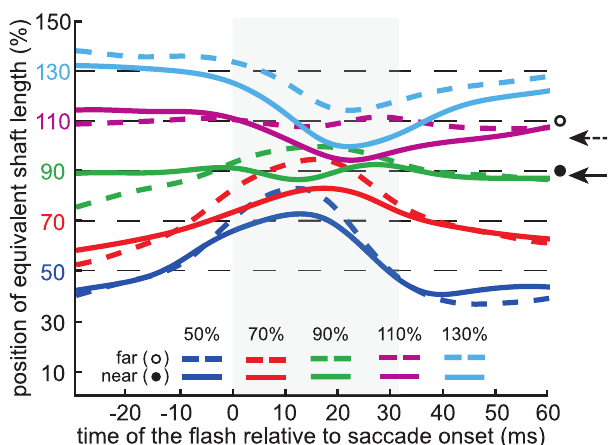
Figure 6. Averaged mislocalization curves for each flash location in the control experiment. Mislocalization was quantified relative to the equivalent shaft length. Dots were 10% nearer or further than the shaft ends in the main experiment (filled and open circles at the right side of the figure). The flash locations are indicated by dashed black lines. Each of the curves was first determined for each participant and dot position and then the curves were averaged across the two nearer and across the two further dots. The horizontal arrows at the right side of the figure represent the average saccade landing positions for the nearer target locations (solid arrow) and the further target locations (dashed arrow). The grey area shows the average saccade duration.